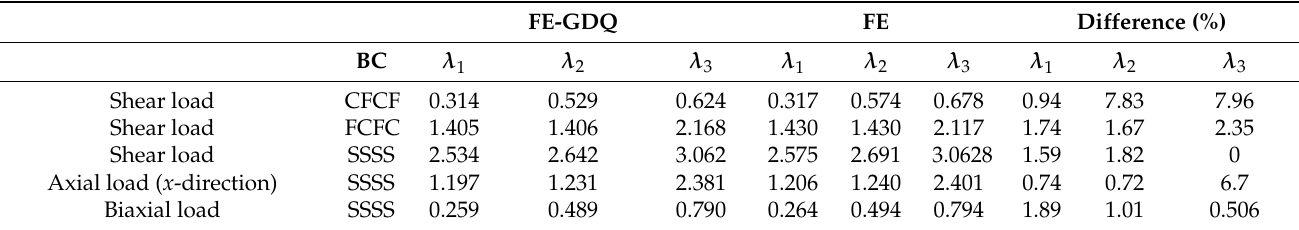
Table 1. Comparative evaluation of the first three buckling loads (10 GPa), as provided by our formulation and from FEM for different boundary